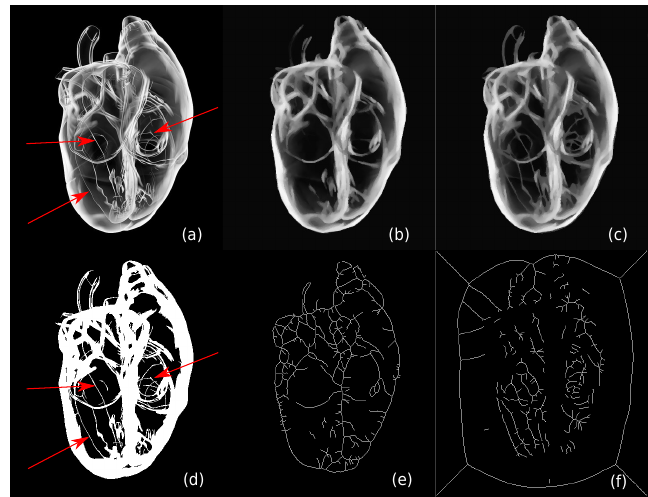
Figure 3. A comparison between reconstructions using the CDMD method ( b ) and our adaptive scheme ( c ) for a heart anatomy image ( a ). ( d ) The threshold-set (layer) 90 of ( a ). ( e ) The skeleton generated for T ↑ . ( f ) The skeleton generated for T 90 ↓ . 90